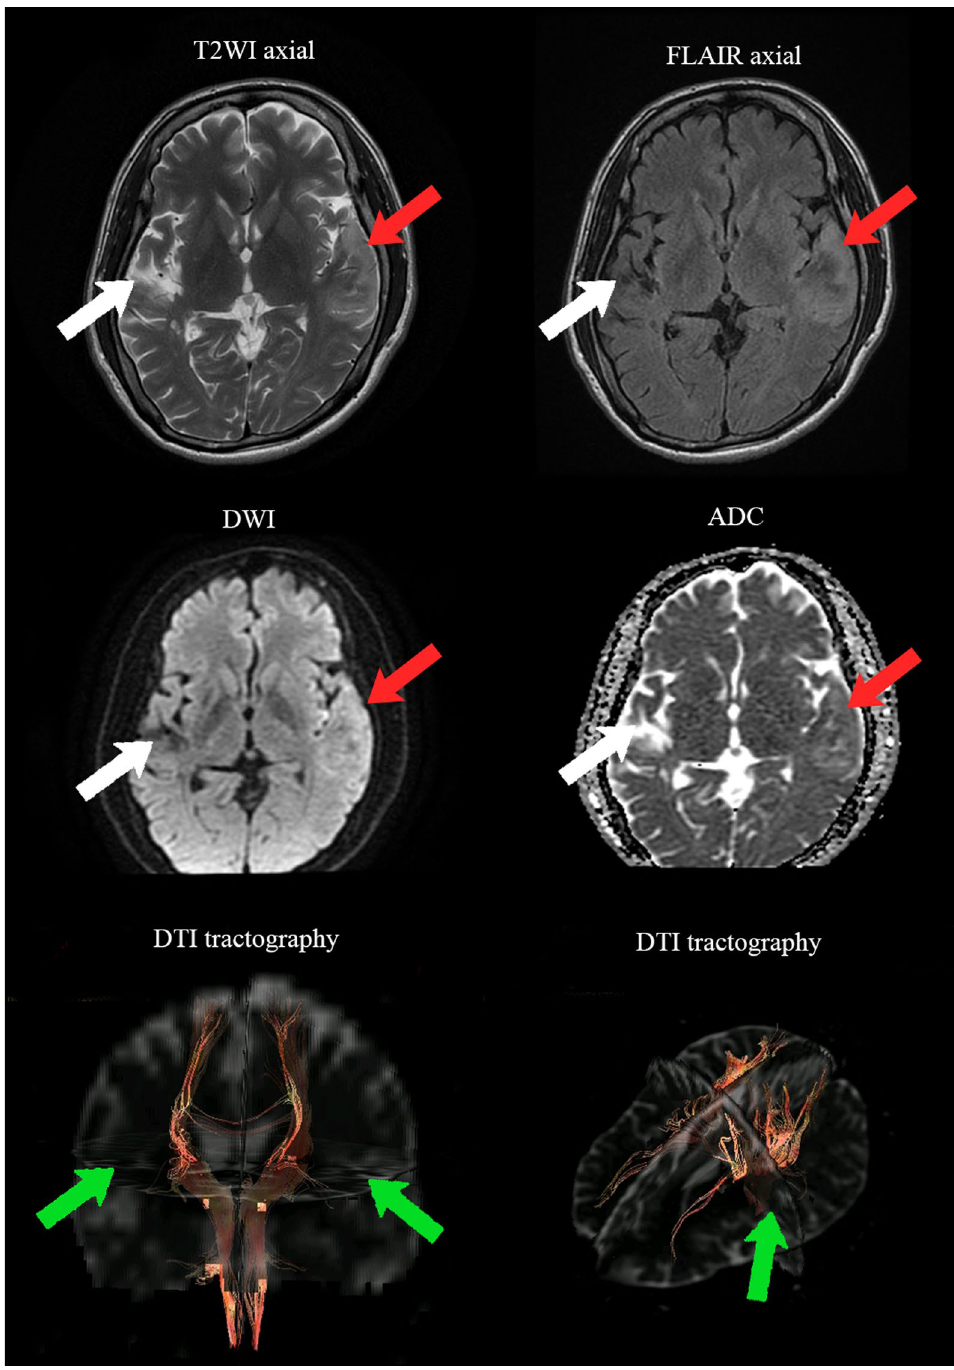
Fig. 1 Brain imaging of cortical deafness in recurrent stroke. Brain MRI showed multiple subacute infarctions in the left anterior and posterior temporal lobe (red arrow), multiple chronic infarctions in the right anterior temporal lobe (white arrow), and focal brain atrophy of the right temporal lobe (white arrow). DTI tractography showed no visible tract from bilateral auditory thalamus towards auditory cortices (green arrow). T2WI, T2 weighted image; FLAIR, Fluid Attenuated Inversion Recovery; DWI, Diffusion-Weighted Imaging; ADC, Apparent Diffusion Coefficient; DTI, Diffusion Tensor